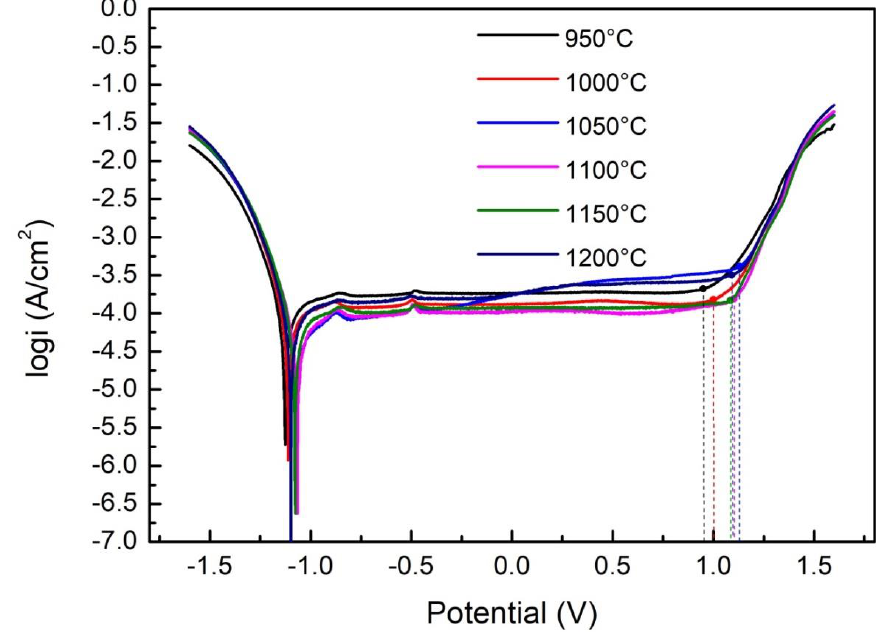
Figure 6. Polarization curves of S32750 stainless steel at different annealing temperatures.